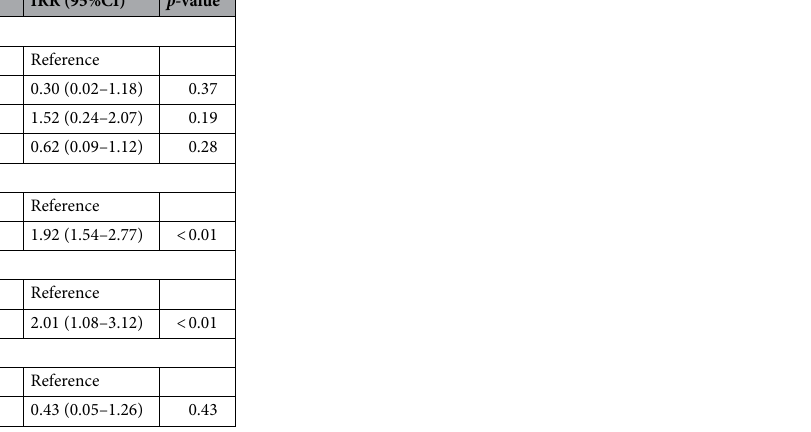
Table 6. Multivariate analysis (negative binomial regression) of number of extraced teeth during APT. Multivariate analysis (negative binomial regression) of the number of extracted teeth due to periodontitis per patient during APT; analysis was corrected for the period of follow-up. APT active periodontal therapy; IRR incidence rate ratio; CI confidence interval; T0 start of